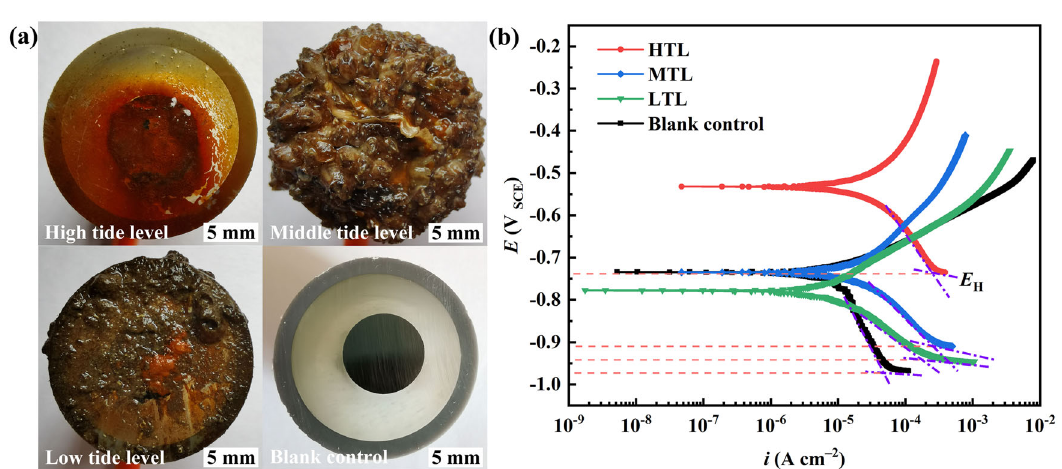
Fig. 7 Potentiodynamic polarisation of the AISI 4135 steel samples in natural seawater. a Macro-morphologies and b polarisation curves of the AISI 4135 steel samples after exposure to the tidal zone for 3 where i a represents the total anodic polarisation current and i h and i b represent the hydrogen permeation and background currents, respectively.